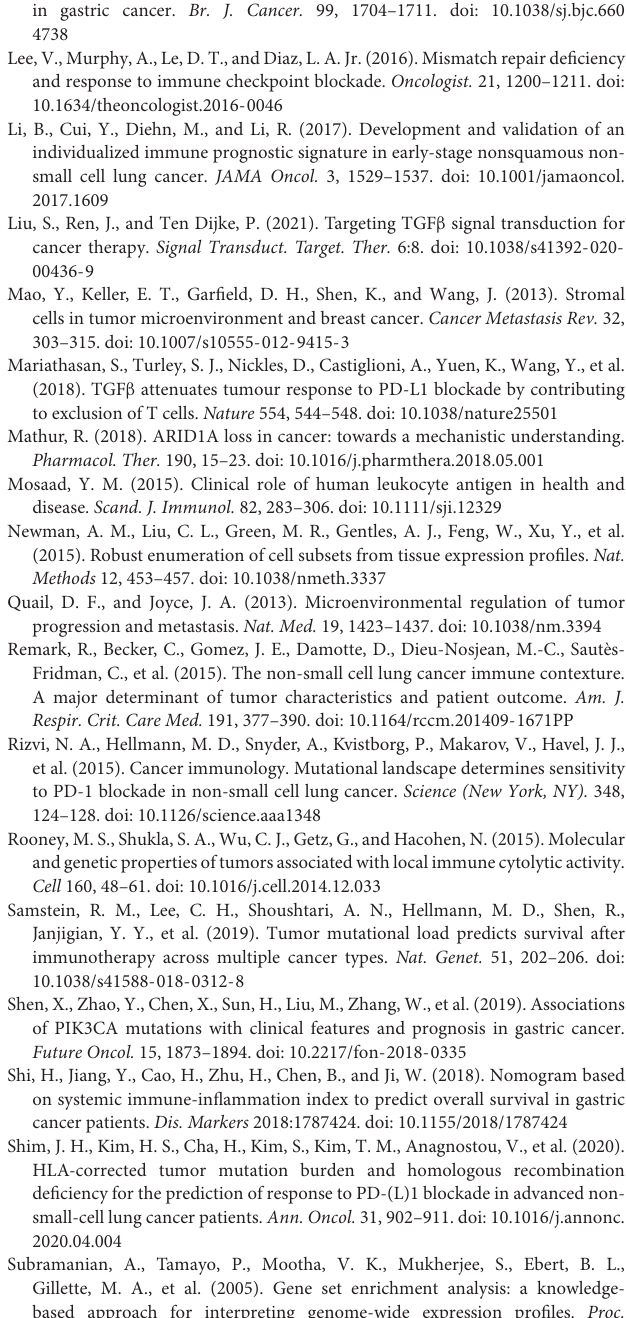
Supplementary Figure 3 | Difference of immune scores and stromal scores between low- and high-risk immune groups in the TCGA training cohort, TCGA testing cohort, and GEO validation cohort. Supplementary Figure 4 | Immune risk signature was associated with human leukocyte antigen (HLA) in the entire TCGA and GEO